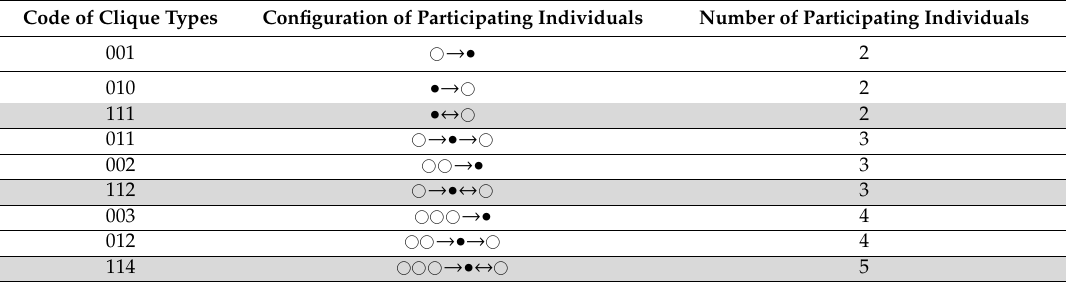
Table 2. Types of grooming cliques during the study period. Black circles indicate the focal individual, white circles indicate the other individuals, → indicates who the grooming was directed toward, ↔ indicates mutual grooming, or indicates two or three individuals simultaneously grooming a (cid:35)(cid:35) (cid:35)(cid:35)(cid:35) focal individual. The gray rows indicate mutual